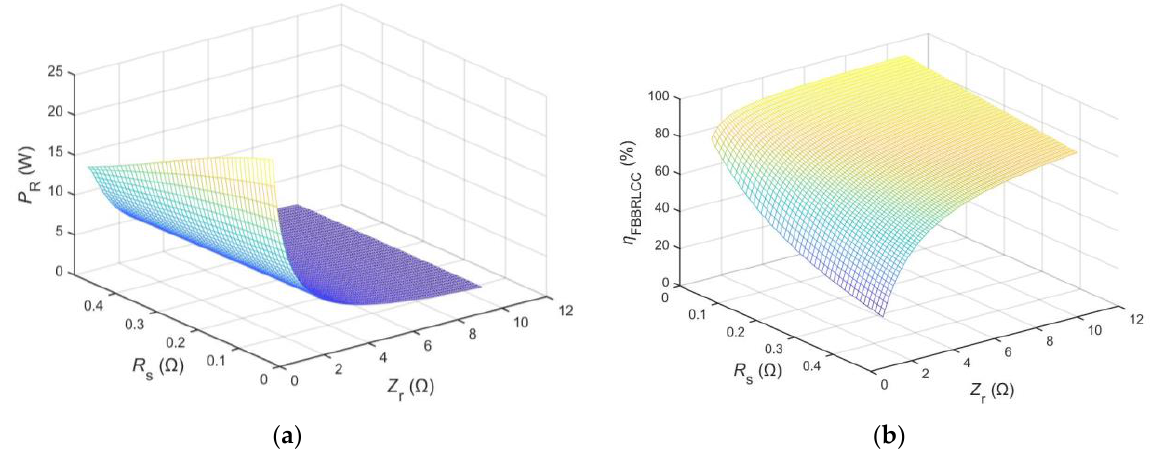
Figure 5. The influence of Z r and R eq on balancing efficiency and average power of the proposed FBBRLCC equalizer at V BR = 12 V and V BC =3.9 V. ( a ) P R versus Z r and R eq . ( b ) η FBBRLCC versus Z r and R eq .